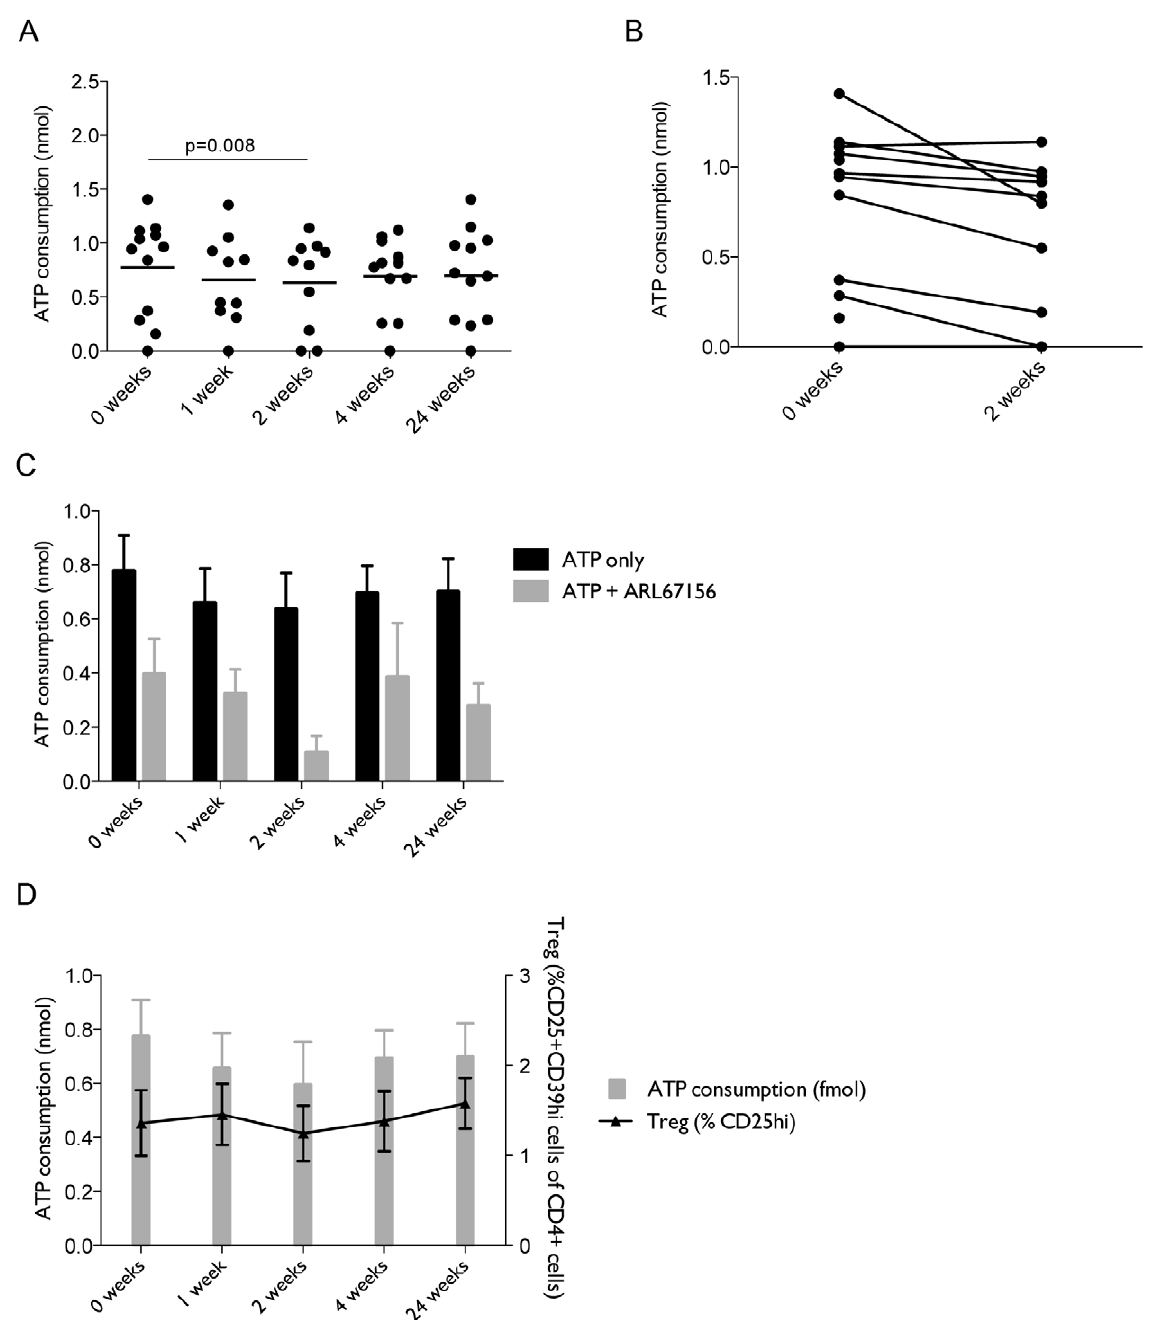
Figure 1. ATP consumption by PBMC and CD39 + Treg percentages dip 2 weeks post-vaccination. PBMC from MVA85A-vaccinated subjects were plated out at 5 6 10 4 cells/well in 50 m L. Cells were incubated with either 50 m M ATP or 50 m M + 100 m M ARL67156 before addition of the luciferase reagent. A standard curve starting at 50 m M ATP was set up and negative controls were cells with no ATP added. (A) Shows change in ATP consumption over time post-vaccination. (B) Paired representation of change in ATP consumption between 0 and 2 weeks post-MVA85A. Effect of addition of ARL67156 is show in (C). (n=10–12). Note that the observation of a greater effect of the inhibitor is potentially due to saturation of binding sites for ATP by the inhibitor at this timepoint, whereas the greater percentage of CD39 + cells present at other timepoints meant the concentration of ARL67156 was not high enough to completely block all available binding sites. Percentages of CD25 + CD39 + Treg in MVA85A- vaccinated subjects were calculated as a percentage of CD4 + T cells and shown in (D), plotted over ATP consumption. doi:10.1371/journal.pone.0023463.g001 Discussion following Ag85A peptide pool stimulation (Fig. 3C) (mean 6 SD M.tb is a resilient intracellular pathogen that has evolved to for WB (1 week post-vaccination): 0.0548% ( 6 0.0355); PBMC (2 survive successfully inside human macrophages in a delicate weeks post-vaccination): 0.0096% ( 6 0.0083), p , 0.001).